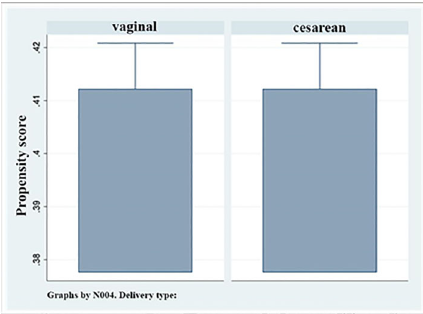
Figure 2. Propensity score boxplot by delivery type. Data are reported as means and standard